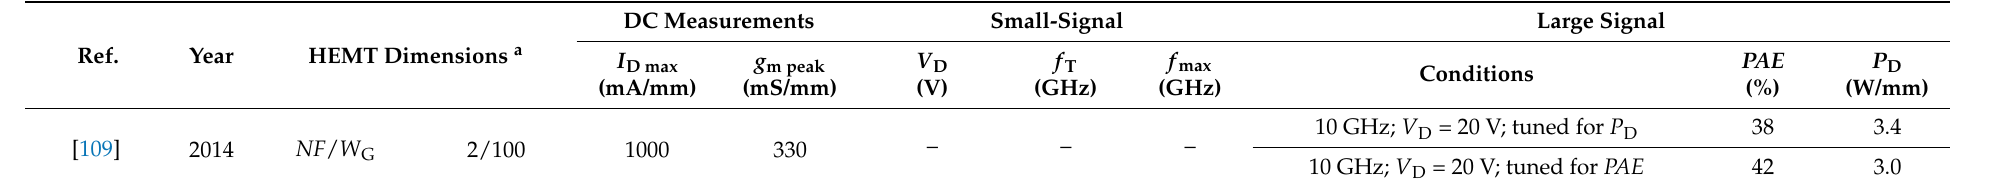
Table A2. Relevant electrical parameters of HEMTs fabricated on GaN/diamond bonded